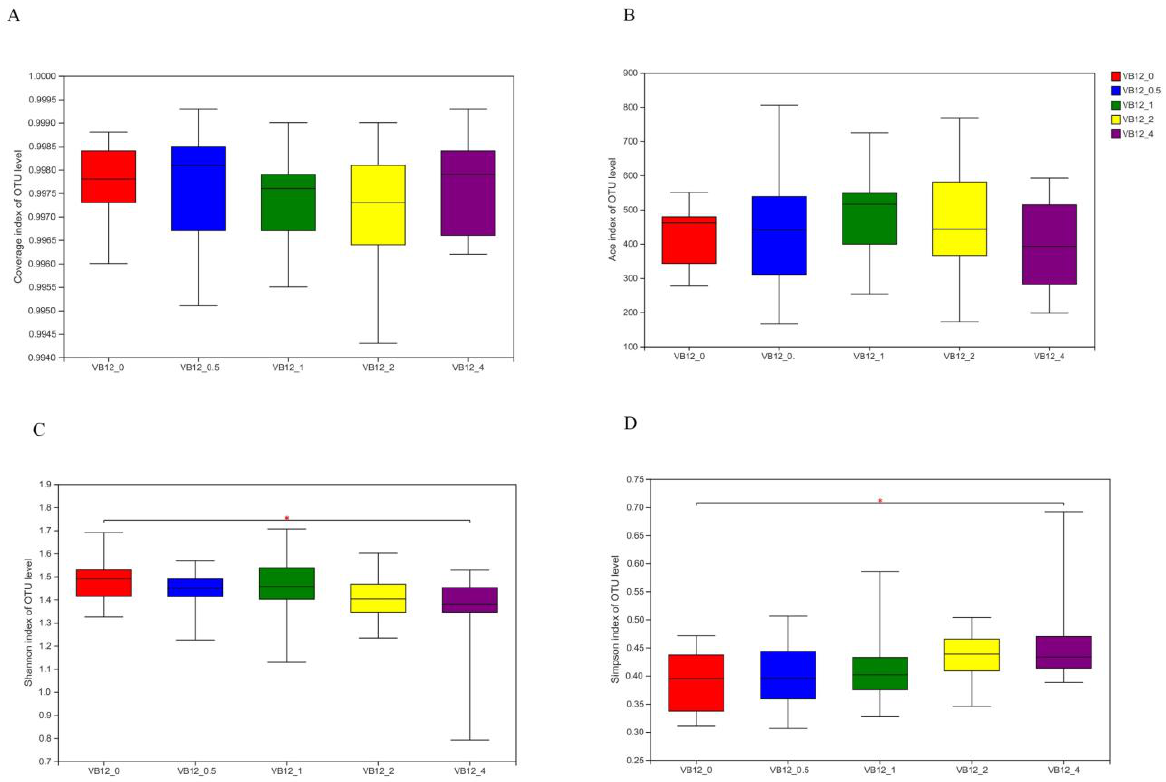
Figure 4. Changes of alpha diversity indices in the archaeal community in the rumen fermentation system with increasing vitamin B 12 supplementation. ( A ) Coverage index; ( B ) Ace index; ( C ) Shannon index; ( D ) Simpson index.